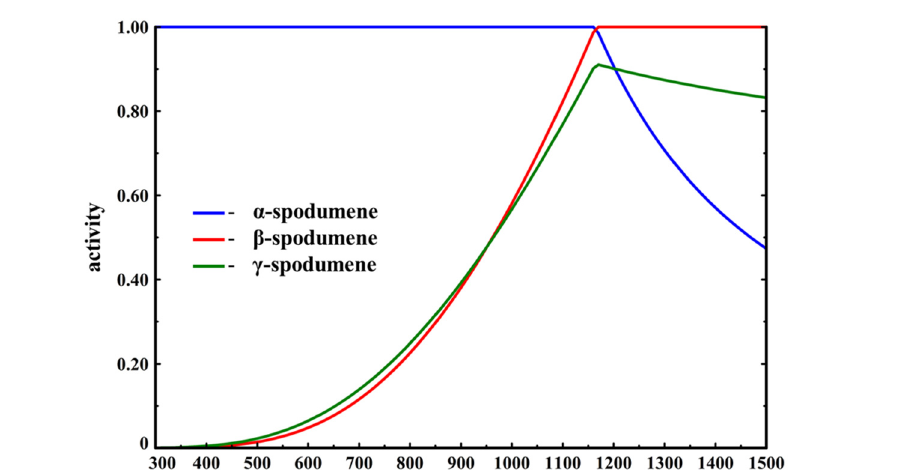
Figure 13. Sensitivity analysis for the activity diagram of the spodumene system with Konar’s data [15] for α -spodumene and β -spodumene and modified γ -spodumene data for the four-element system (Li + Al + 2 Si + 3 O 2